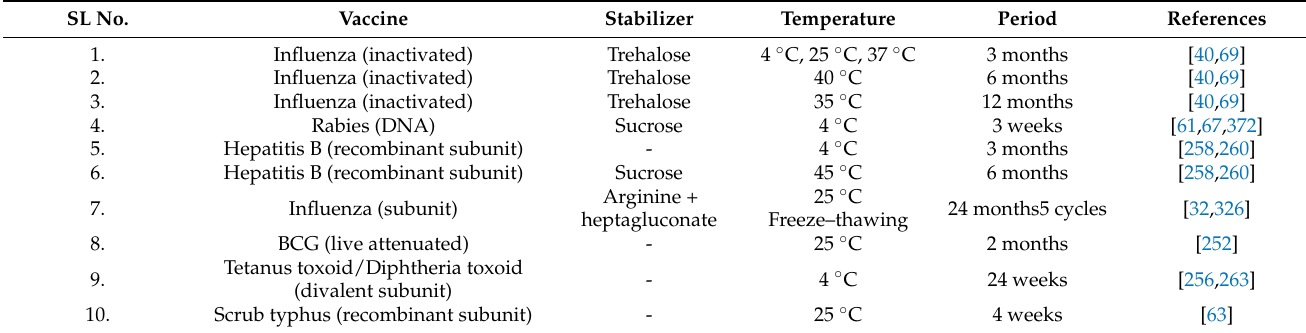
Table 9. Stability studies of vaccine DMAP.